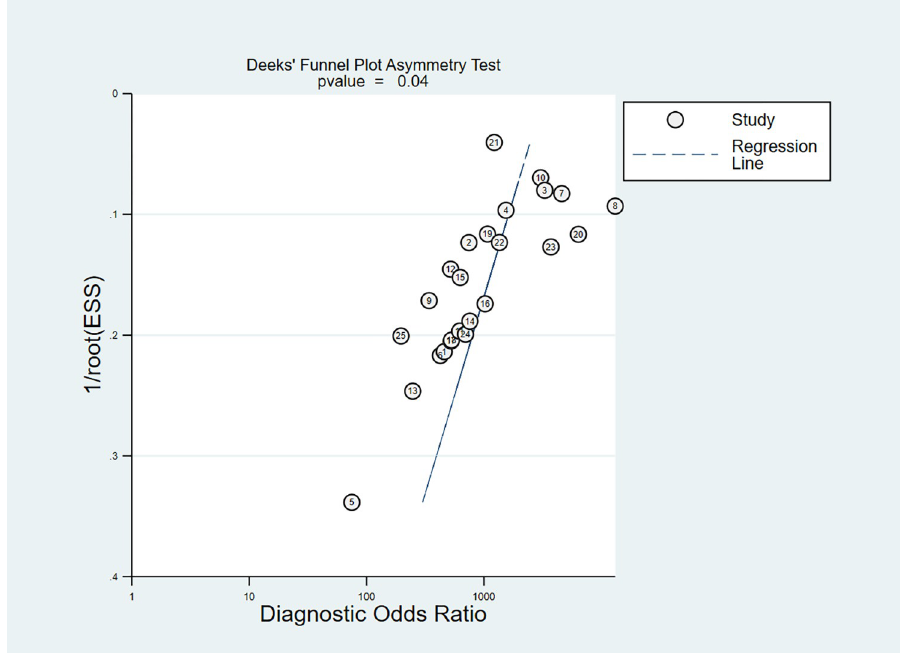
Fig 4. Deek’s funnel plot.